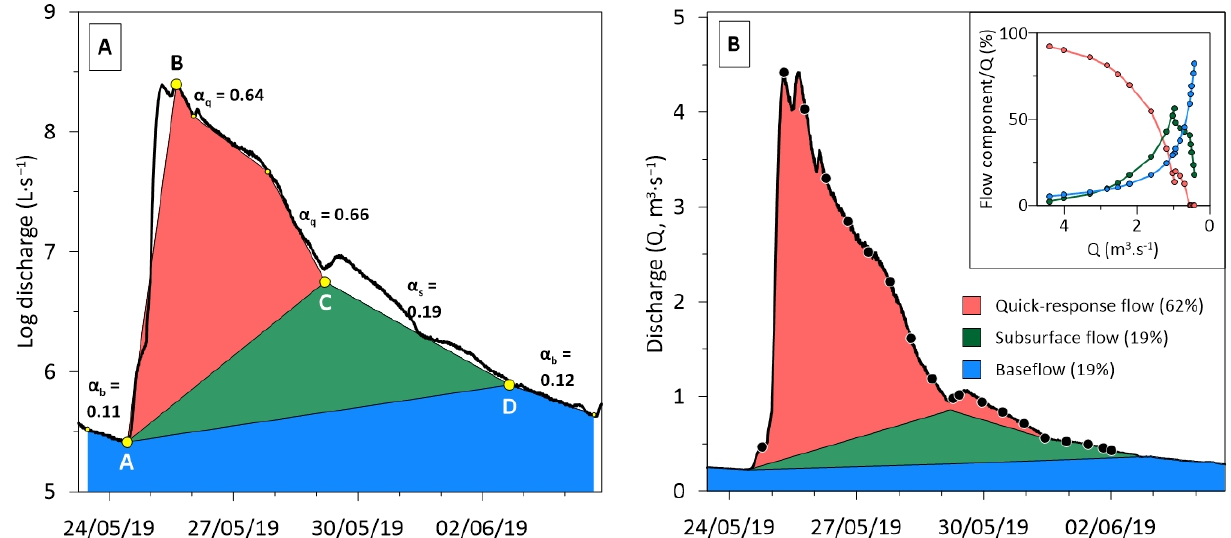
Figure 2. Hydrograph separation in logarithmic scale ( A ) and in normal scale ( B ) of the different streamflow components foron the flood event 2 with their respective recession coefficients ( α q, α s, α b, corresponding to t in days, see (Equation (2)). The embedded small graph in Figure 2B, exhibits the relationship between the discharge contribution of each flow component (%) and the total stream discharge during the recession period. The black points on the Figure 2B correspond to water sampling.